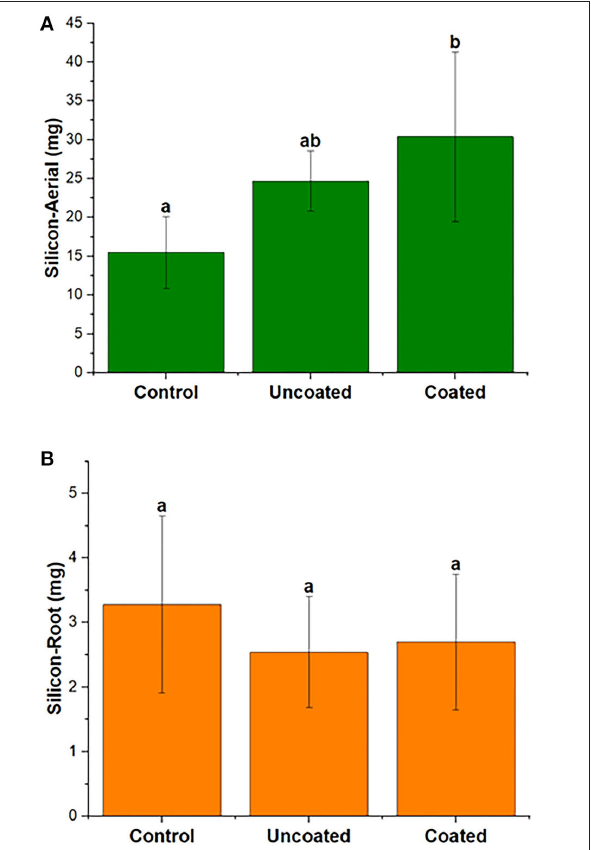
FIGURE 5 | (A) Plant height and (B) yield of spring rye, representing control, uncoated, and coated treatments. Lowercase letters (a–e) indicate significant differences between treatments ( p < 0.05).